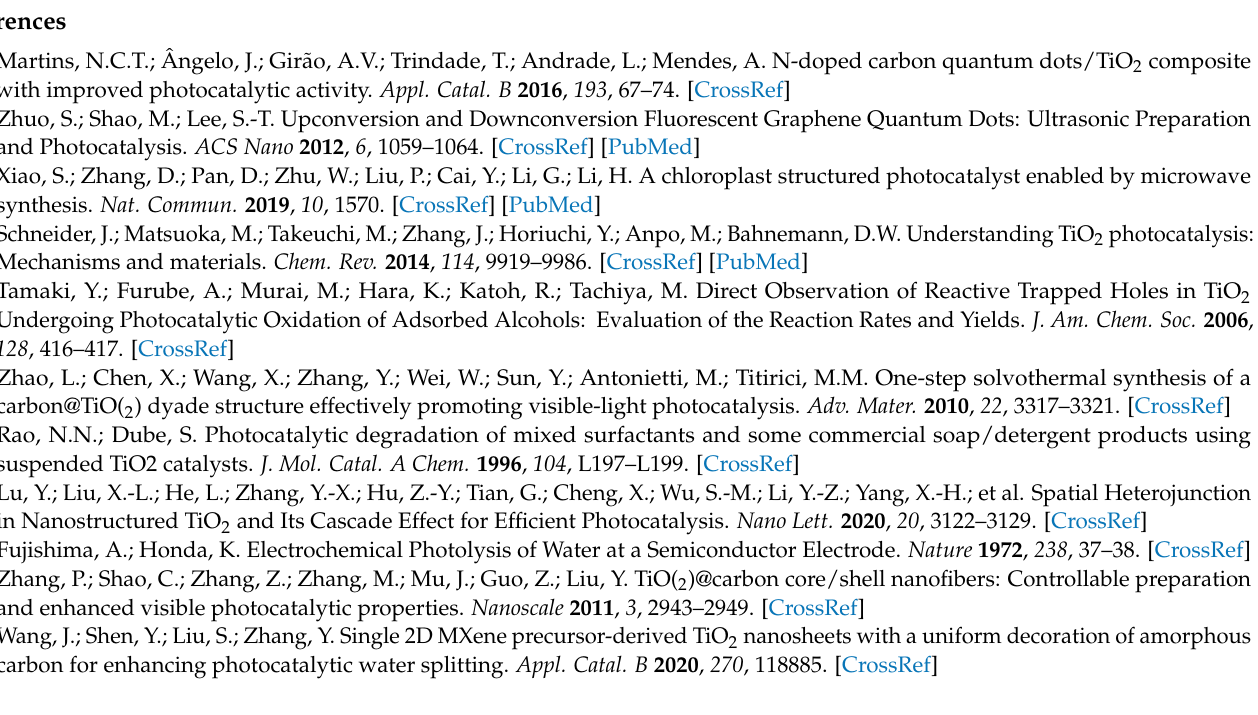
CDs. Figure S2: Photoluminescence spectrum of CDs with different excitation (add